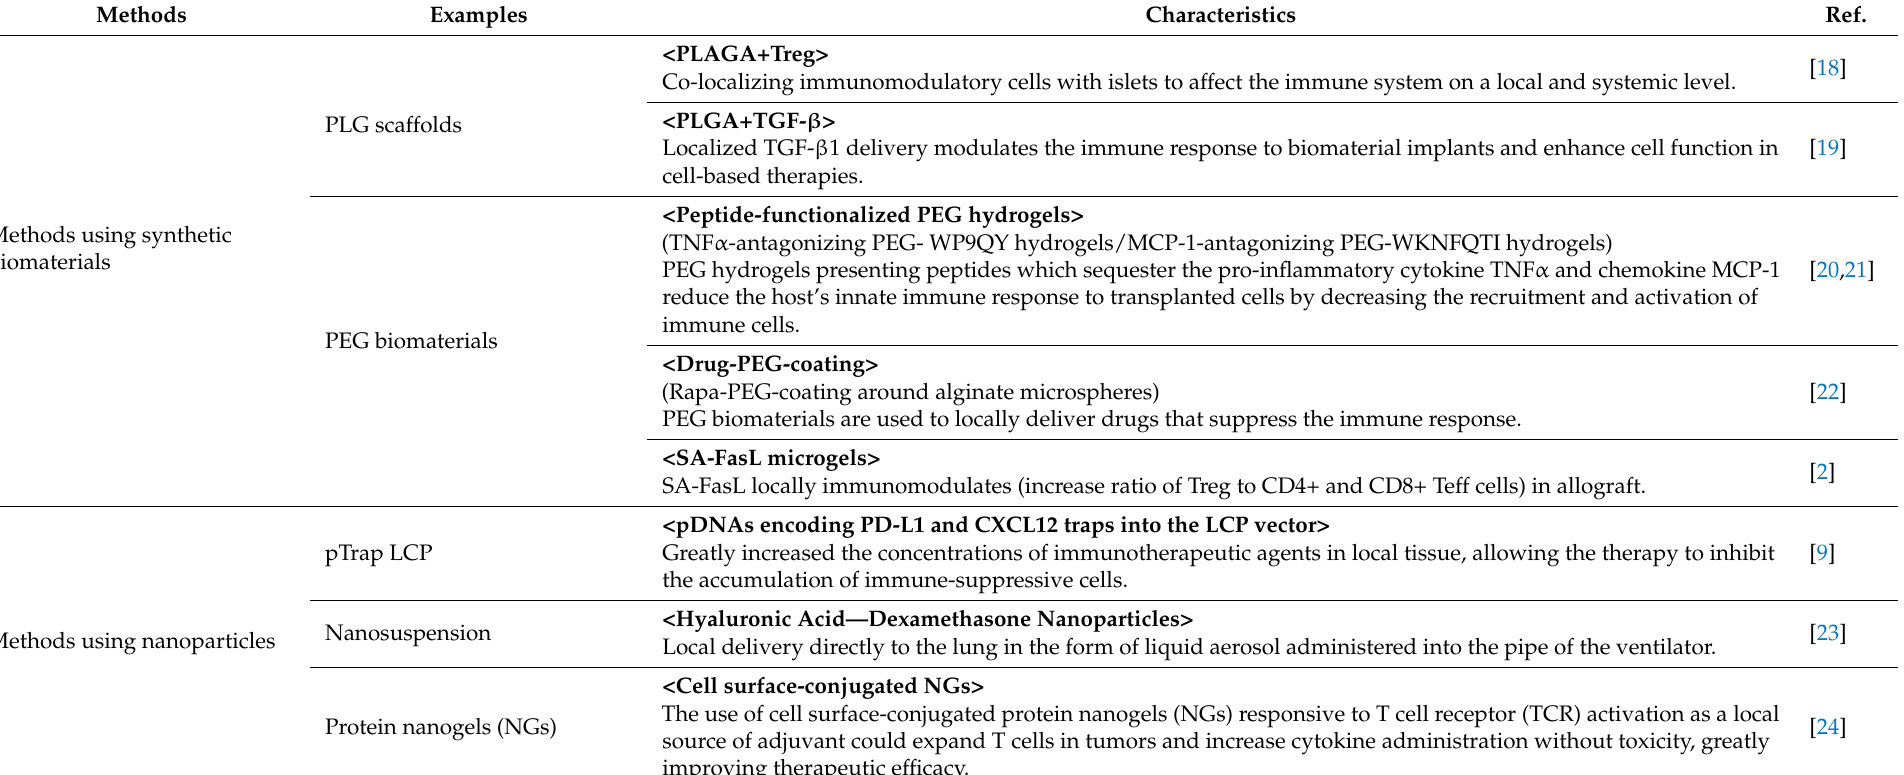
Table 1. Recent technologies for local